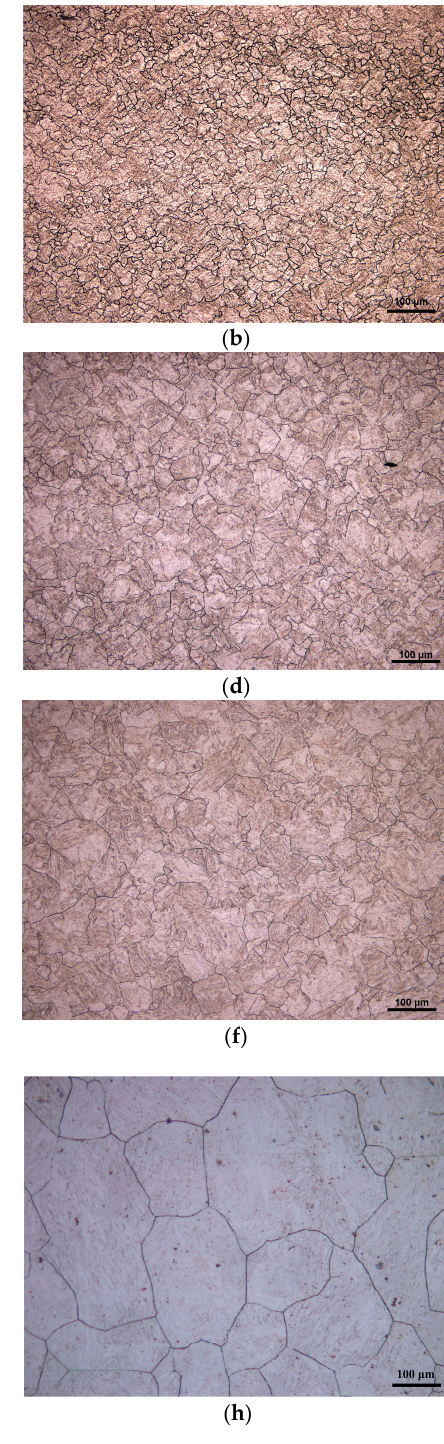
Figure 3, the flow stress curves all reach a steady state when strain equals a certain value, which indicates that dynamic recrystallization is complete.